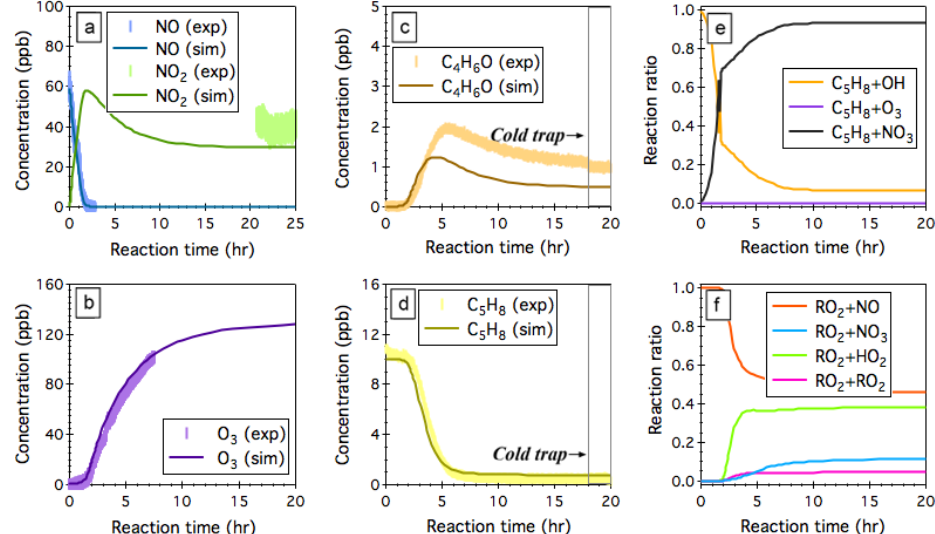
Figure 5. Simulated (sim.) and observed (exp.) evolution patterns of (a) NO x , (b) O 3 , (c) the sum of MACR and MVK (C 4 H 6 O), and (d) isoprene (C 5 H 8 ) over 20h NO 3 -initiated oxidation of isoprene under continuous flow mode chamber operation. The fractions of isoprene that reacts with OH, O 3 , and NO 3 are given in panel (e) , and the fractions of INOO radical that undergoes bimolecular reactions with NO, NO 3 , HO 2 , and RO 2 are given in panel (f) . Initial experimental conditions are 0ppb O 3 , 59ppb NO x , and 10.2ppb C 5 H 8 , with continuous input of 205ppb O 3 , 59ppb NO, and 10.2ppb C 5 H 8 over the course of 20h dark